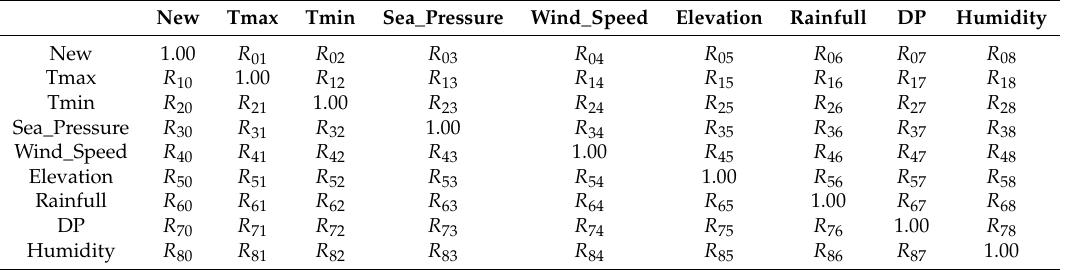
Table 2. Correlation Coefficient